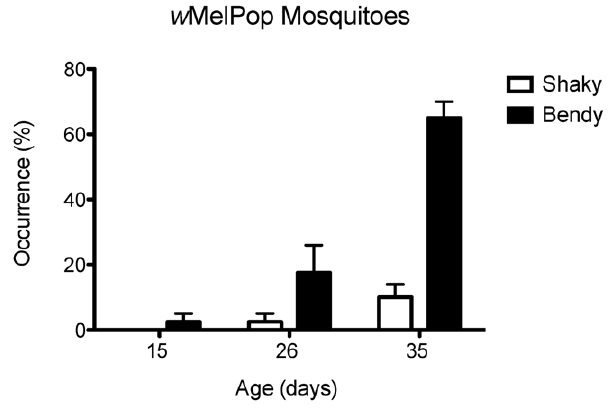
Figure 5. Additional phenotypes observed in Wolbachia -infect- ed A.aegypti . Proportion of w MelPop-infected mosquitoes exhibiting abnormal pre-probing behavior as: body jittering (‘‘shaky’’) or bended proboscis (‘‘bendy’’) in mosquitoes from their first occurrence at 15 days of age. Bars depict medians 6 quartiles for four replicate experiments, each based on 10 individual mosquitoes. Neither of these behaviors was observed in Wolbachia non-infected mosquitoes.